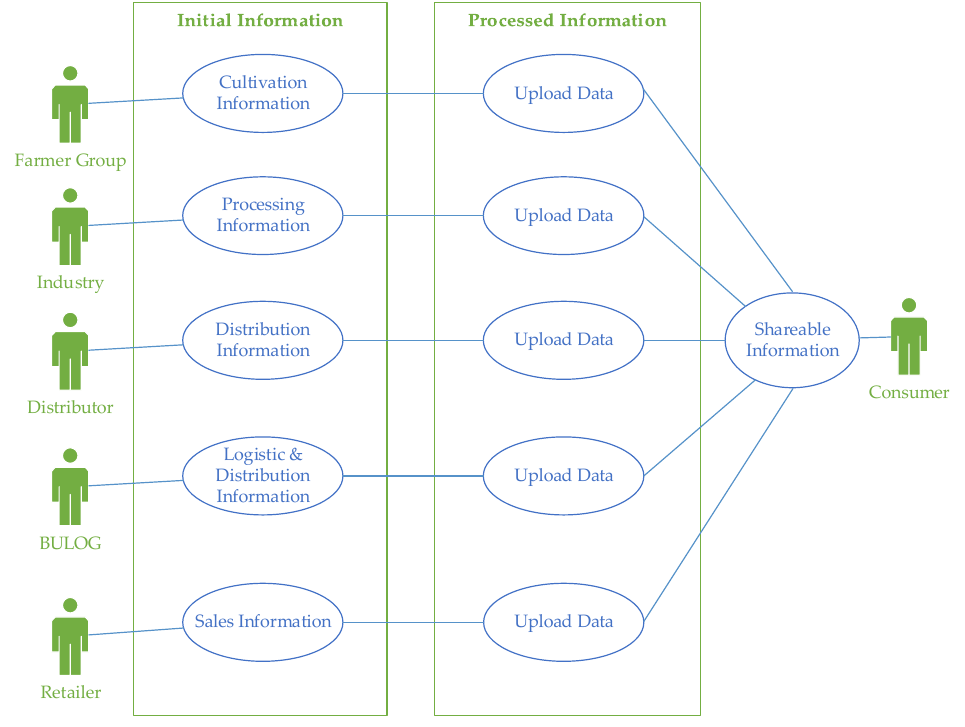
Figure 1. Rice supply chain in West Java Province.